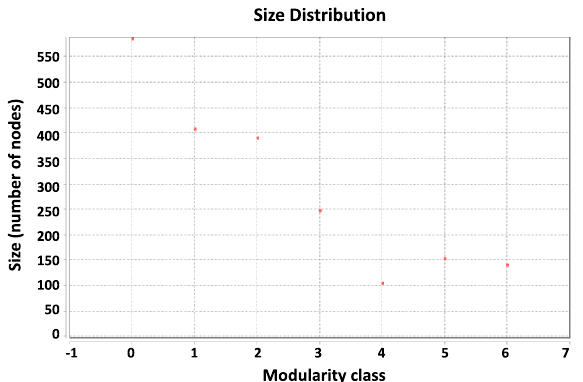
Figure 1. Size distribution of protein communities of NIS expression regulatory network. 7 communities were detected, and the modularity score was calculated 0.411.